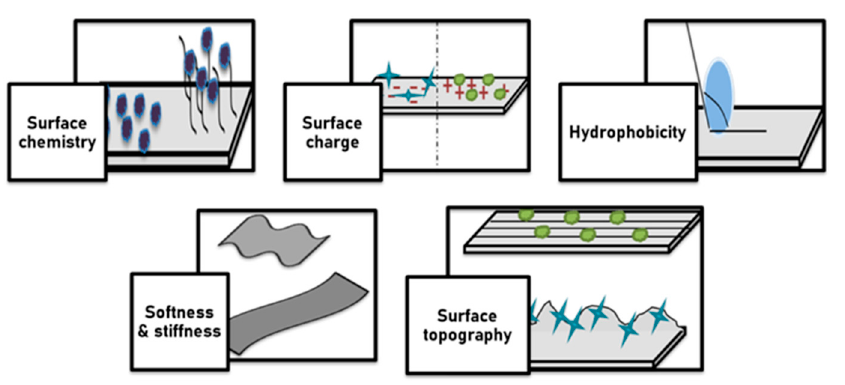
Figure 7. Diagrammatic representation of effect of surface modification of cellular behaviour, which includes changes in surface chemistry, surface charge, hydrophobicity, softness and stiffness, and surface topography (roughness and alignment).